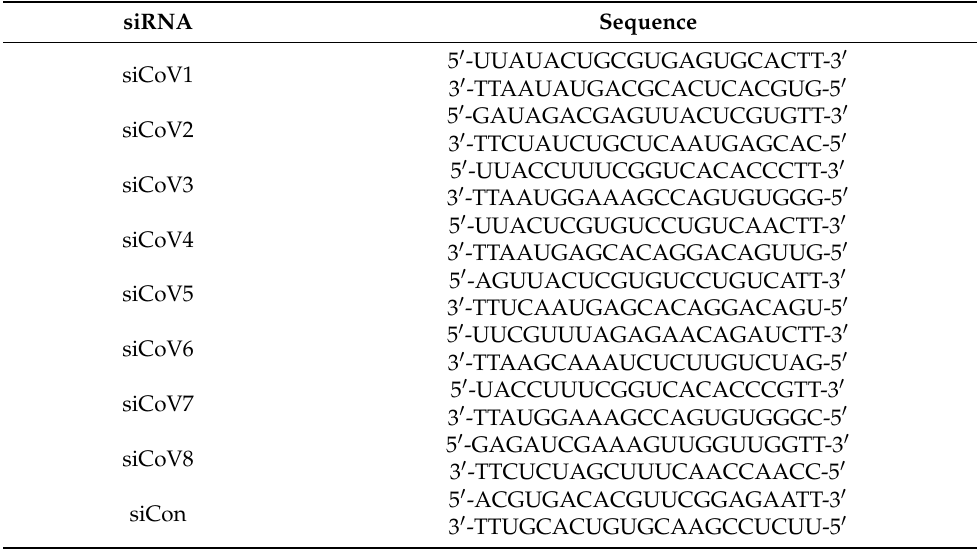
Table 1. Sequences of designed